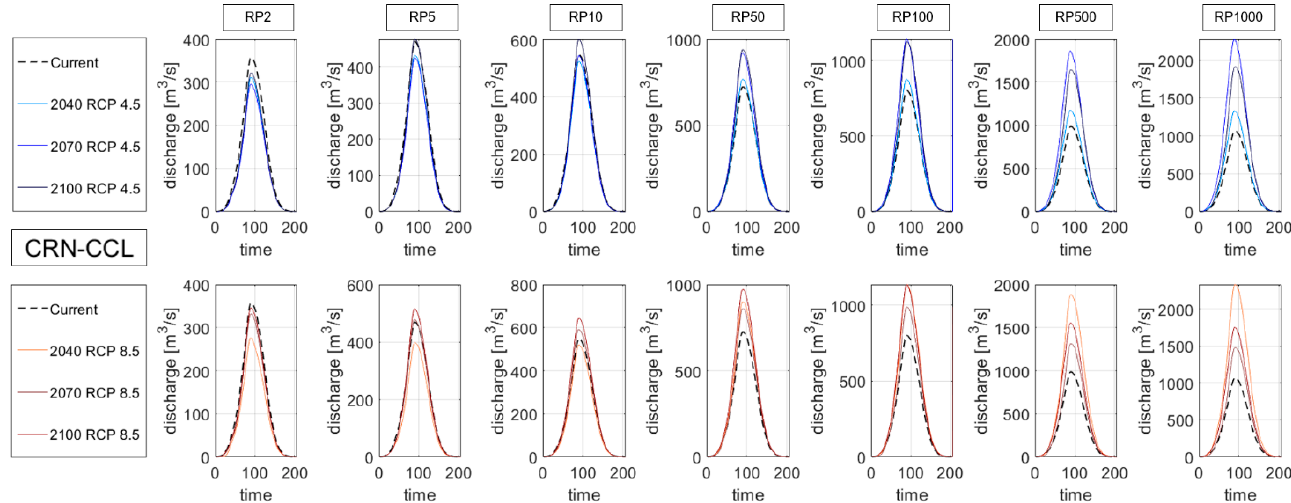
Figure 7. Hydrographs for the current (dashed black) and climate change (colored) scenarios for the CNR-CCL climate